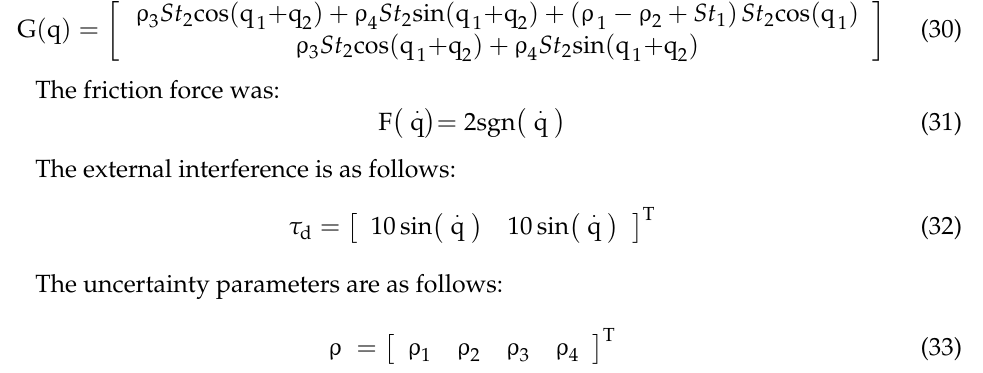
Figure 3. Pseudo-code of the proposed algorithm.